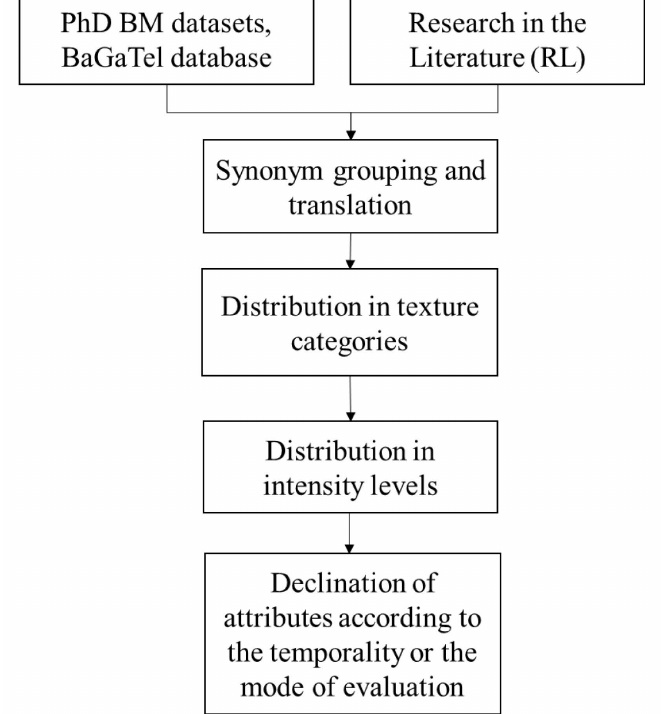
Figure 2. Scheme of attribute grouping steps (origin of attributes, grouping into categories, intensity levels and